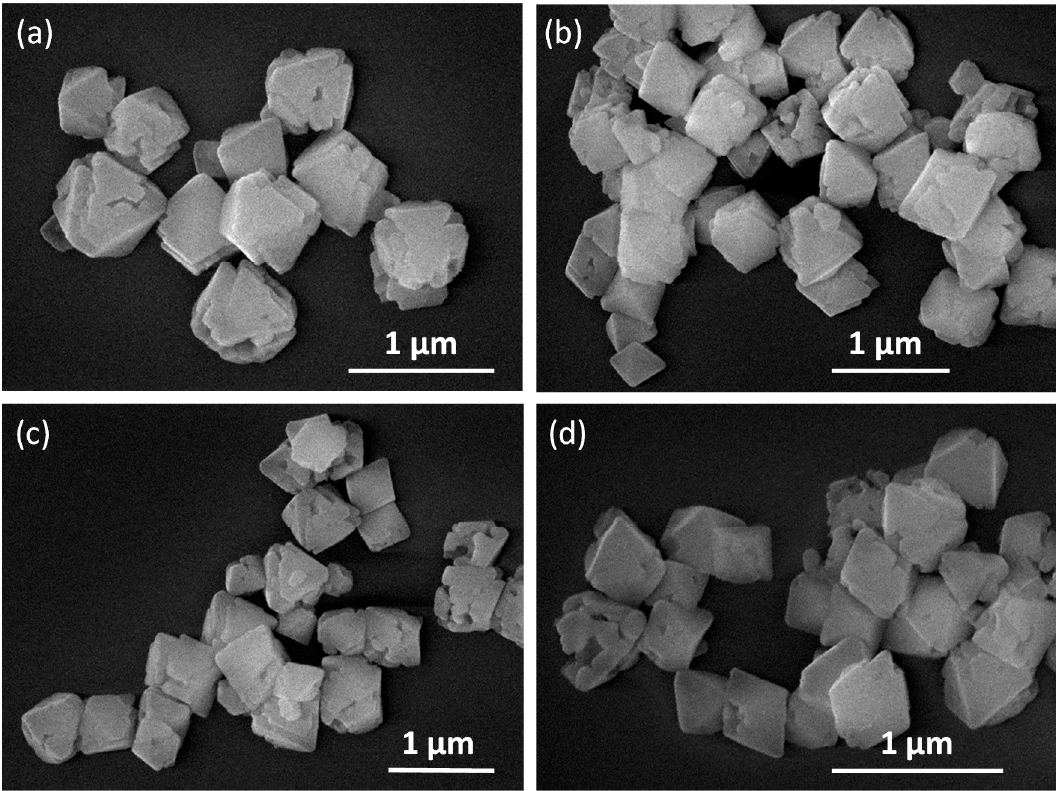
Figure 7. FESEM images showing the stability of 1n obtained heating at 40 °C, 5 min and leaving the solution 20 h at 25 °C ( c experimental conditions) versus pH: ( a ) pH = 5.5, average size of 534 ± 85 nm ( b ) pH = 5.7, average size of 480 ± 93 nm; ( c ) pH = 5.9, average size of 474 ± 85 nm; and ( d ) pH = 7, average size of 471 ± 84 nm. The means and standard deviations were calculated from values corresponding to 60 particles from FESEM images.